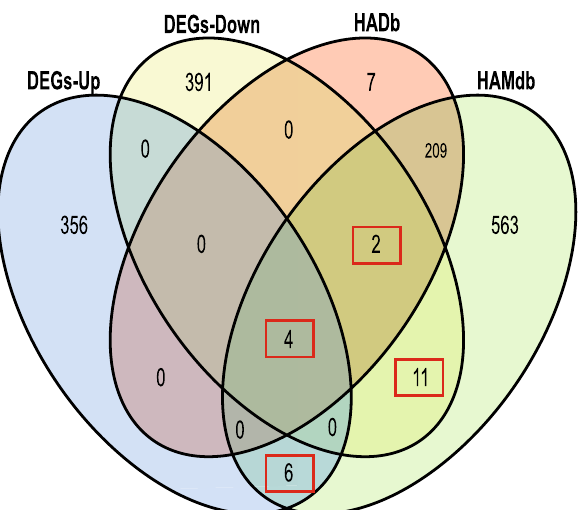
Figure 3. AR-DEGs were shown by Venn diagram. 366 DEGs-Up and 404 DEGs-Down were intersected with 232 and 796 autophagy-associated genes from the HADb and HAMDb autophagy gene pools, with 23 genes being identical. The number of intersecting genes was marked in the red box. DEGs-Up, differentially expressed up-regulated genes; DEGs-Down, differentially expressed down-regulated genes.